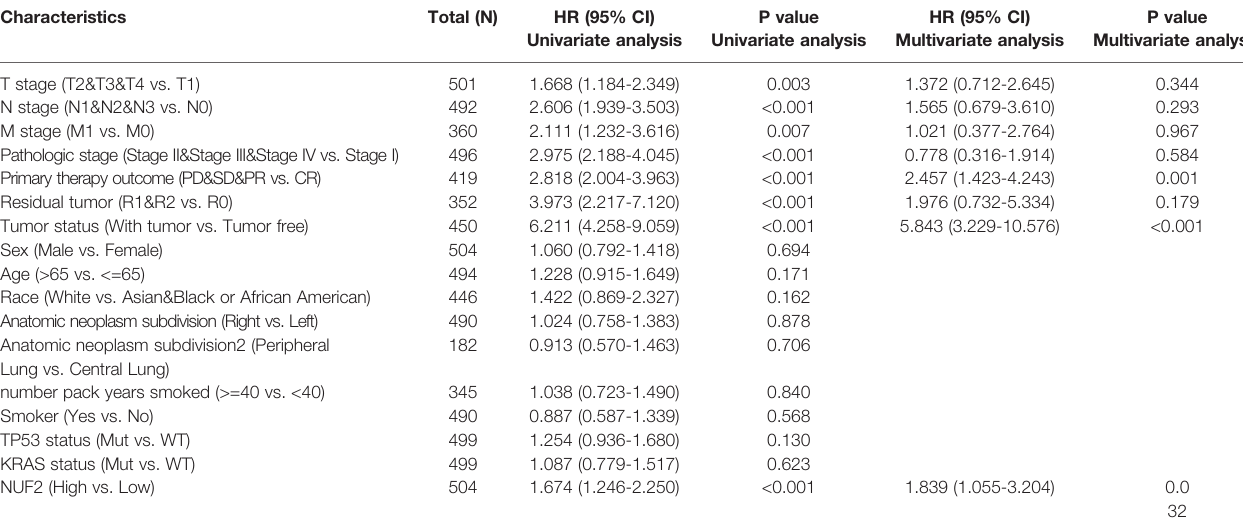
TABLE 4 | Univariate and multivariate Cox